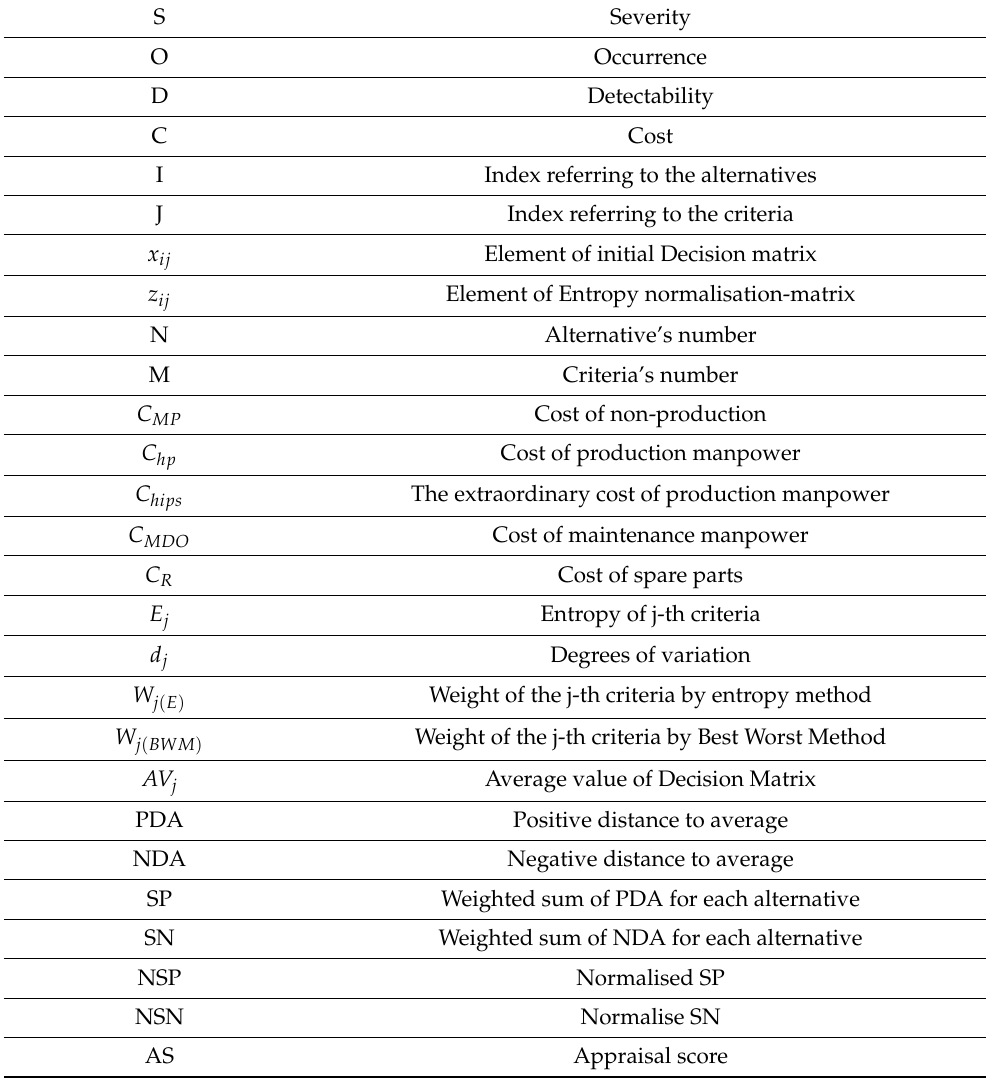
Table 2. Nomenclature